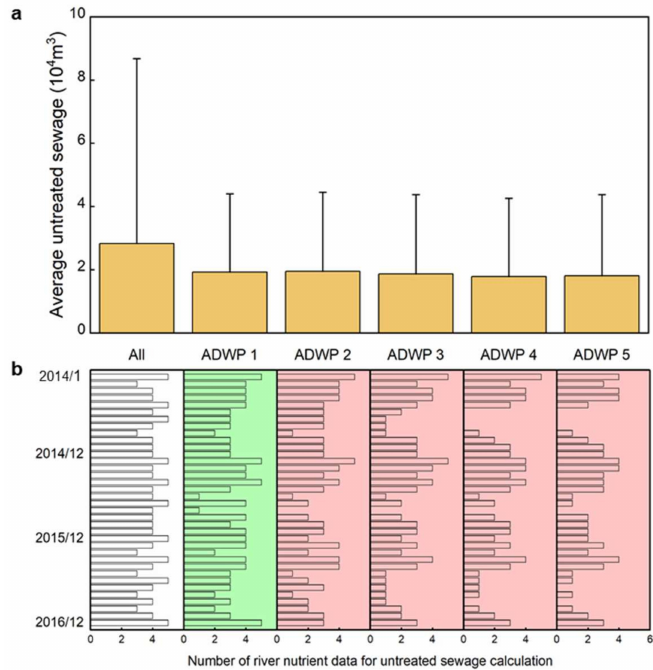
Figure 5. ( a ) The three-year average and ( b ) monthly data coverage of untreated sewage under six antecedent dry weather period (ADWP) scenarios. The green shaded area in scenario ADWP 1 represents monthly data coverage in the three-year period. Red shaded areas mean the presence of data